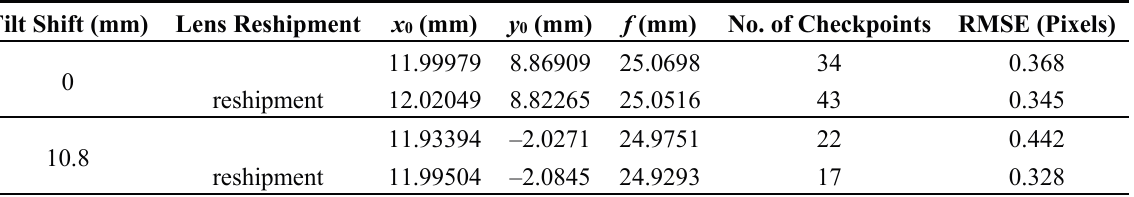
Table 6. Camera’s inner orientation elements in the lens reshipment experiment, unit: mm.